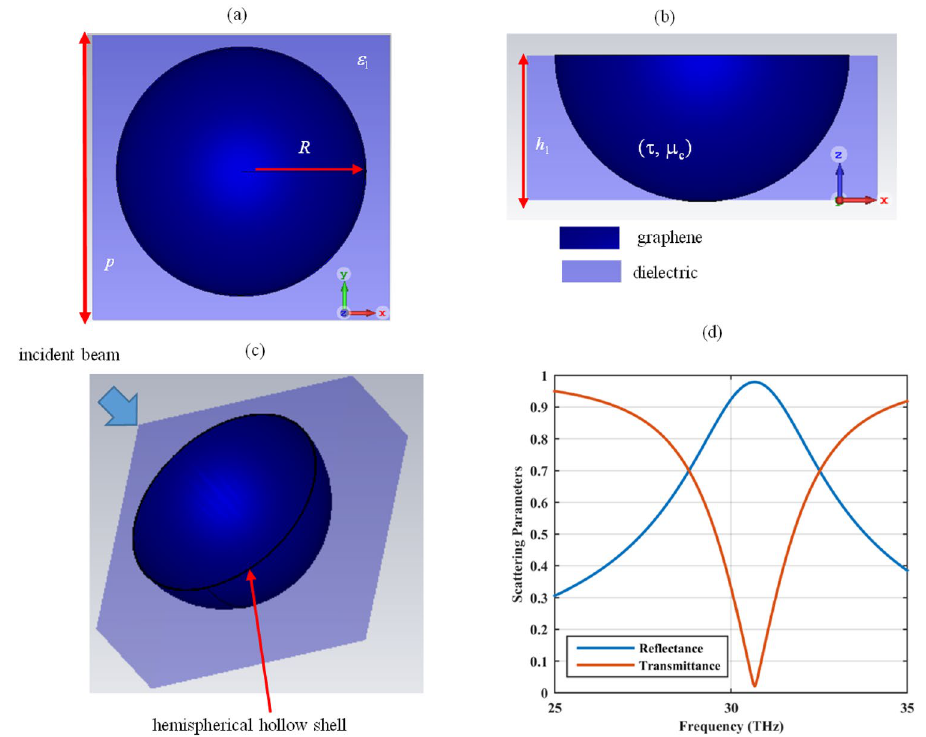
Figure 1. ( a ) Top, ( b ) side and ( c ) three-dimensional views of the proposed unit cell designed using the graphene-coated dielectric hole array ( d ) its reflectance and transmittance. Note that the graphene sheet is wrapped around the sidewalls of the holes. The parameters are as follows: R = 100 nm, ε 1 = 2, h 1 = 100 nm, τ = 2 ps, and µ c = 1.5